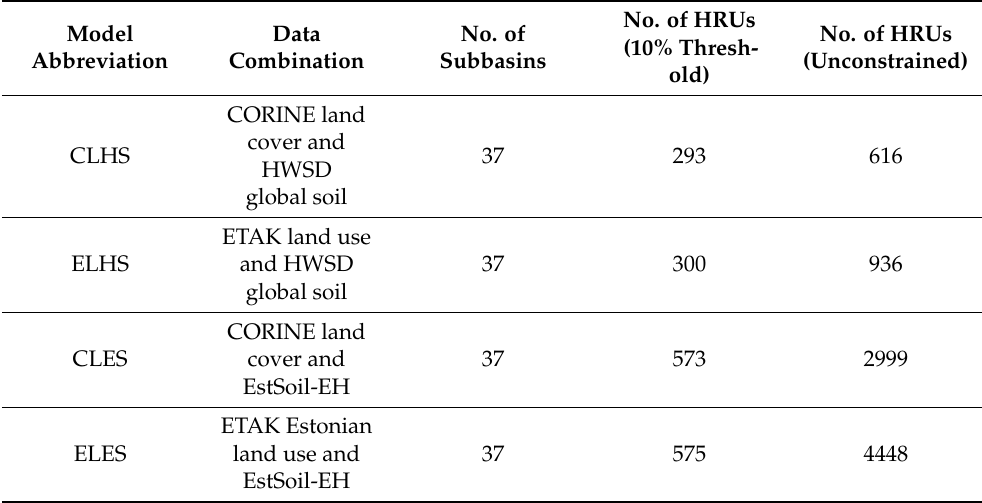
Table 2. Description of the SWAT model setup. In addition to the model setups used throughout the study (10% threshold), we recorded the full theoretical number of HRUs based on the initial QSWAT overlay